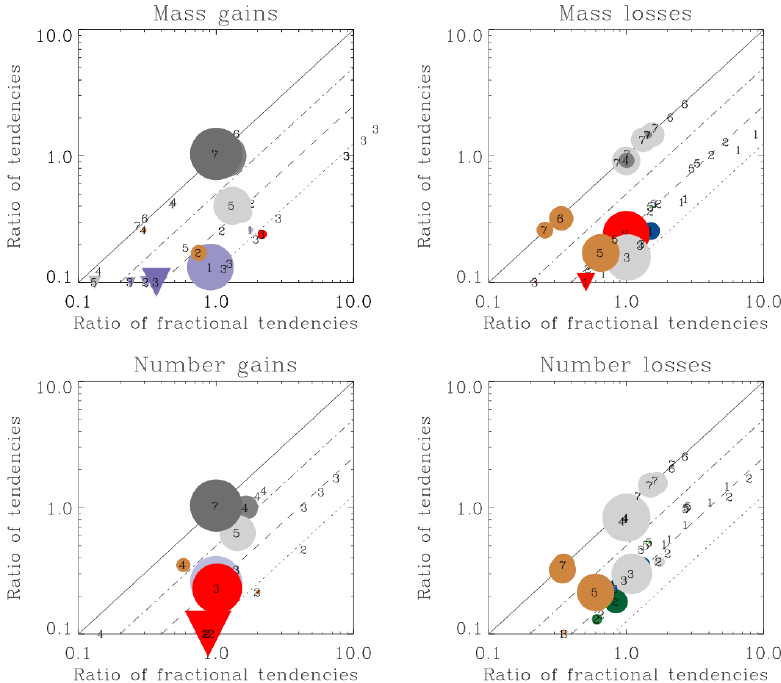
Figure 26. Pre-industrial (PI) to present-day (PD) ratios of absolute tendencies against PI to PD ratios of fractional tendencies. Colors indicate processes (Table 2), numbers indicate modes (Table 3). The size of the symbol indicates fractional tendency in the PD experiment, with the largest symbols having a fractional tendency of about 1 (linear scale). The slanted lines represent y = 2 − n x , with n = 0 , 1 , 2 , 3. Results are shown for North